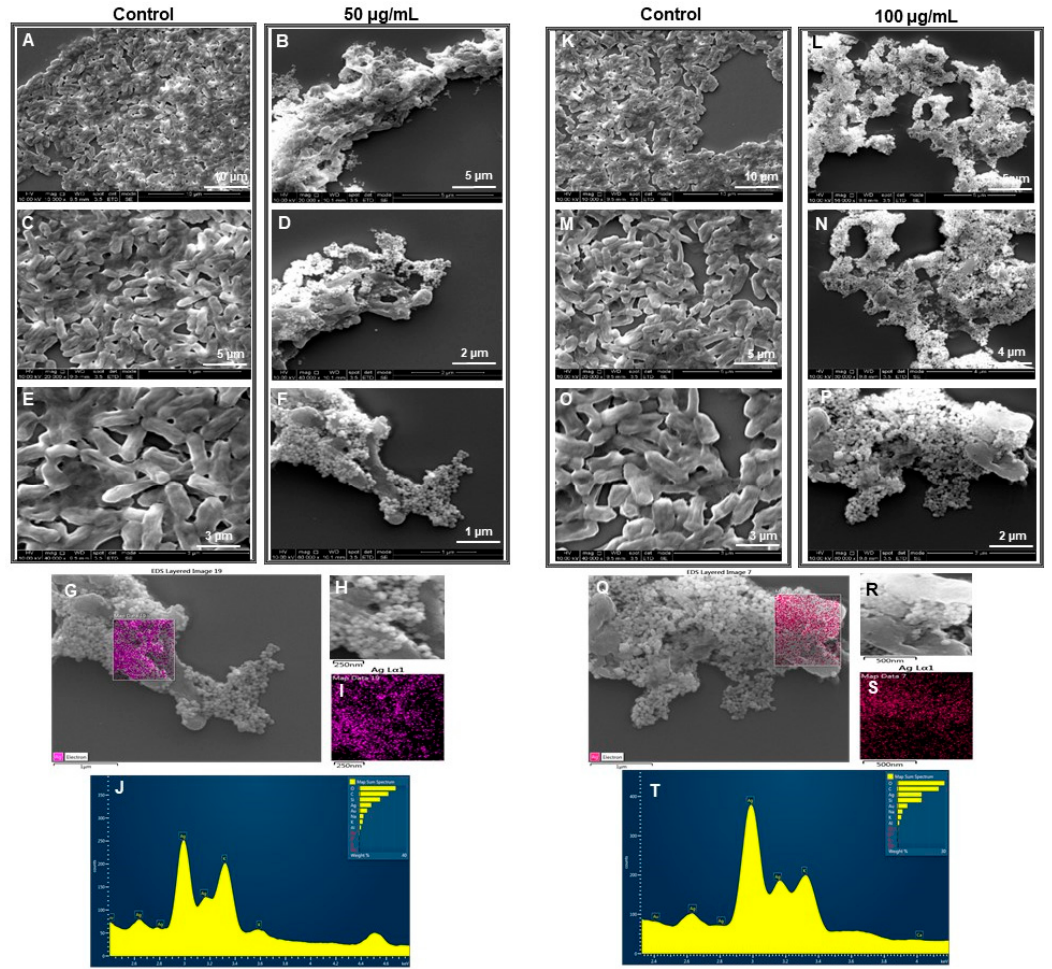
Figure 10. SEM analysis of P. aeruginosa cells after treatment with RB-AgNPs. ( A–F ) Control cells and RB-AgNPs treated cells with 50 µg/mL at different scales. ( G ) Scanned image of treated cells ( H , I ) elemental mapping of the selected area showing silver element in the treated cells, ( J ) EDX spectrum of the chosen area showing peak for silver element. ( K–P ) Control cells and RB-AgNPs treated cells with 100 µg/mL at different scales. ( Q ) Scanned image of treated cells ( R , S ) elemental mapping of the selected area showing silver element in the treated cells, ( T ) EDX spectrum of the chosen area showing peak for silver element.